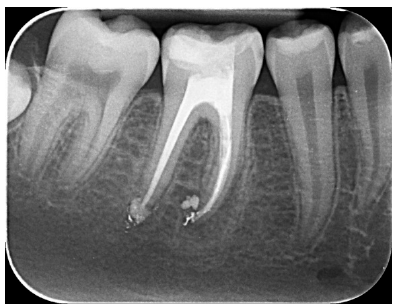
Figure 3. Postoperative periapical radiographic aspect.